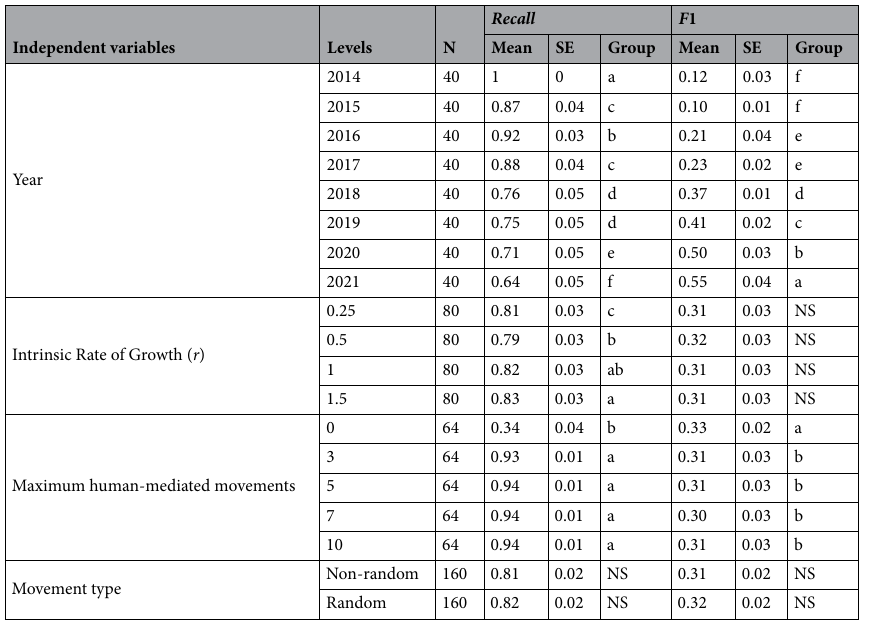
Table 2. Summary of Recall and F 1 model evaluation metrics (mean and SE) among independent variables and post-hoc test pair-wise comparison results (Group). Lowercase letters ‘a–f’ indicate group membership and ‘NS’ indicates no significant